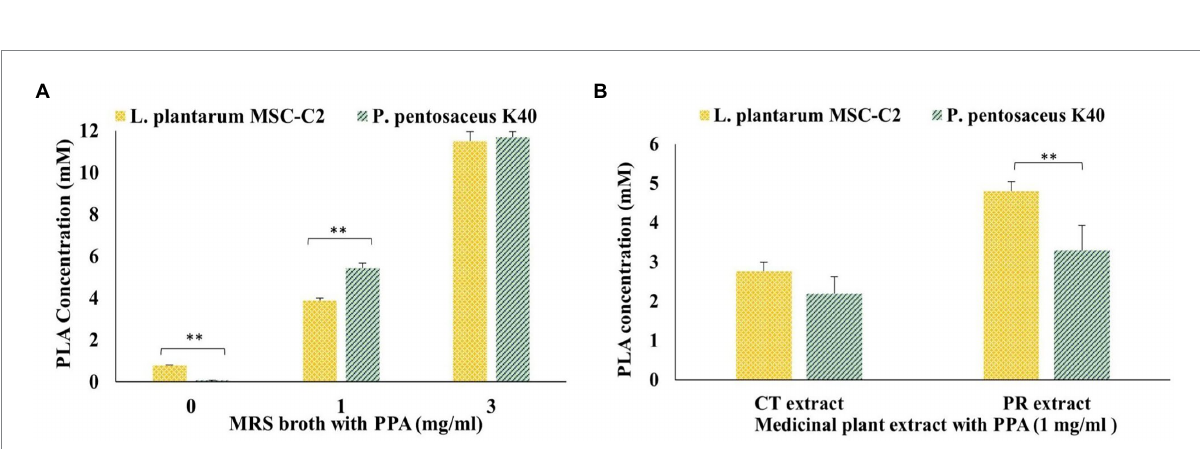
FIGURE 3 Concentration of PLA produced by MSC-C2 and K40 (A) , in MRS broth supplemented with or without PPA and (B) , in the PR extract and CT extract supplemented with PPA (1 mg/ml). The PLA concentrations were measured via HPLC after ethyl acetate extraction from the CFS and determined using a standard PLA concentration curve. Data represent the mean value from three independent assays in triplicate, and error bars represent the standard deviation (SD). Differences between groups were determined via one-way ANOVA. ** p < 0.05 between the groups represented in